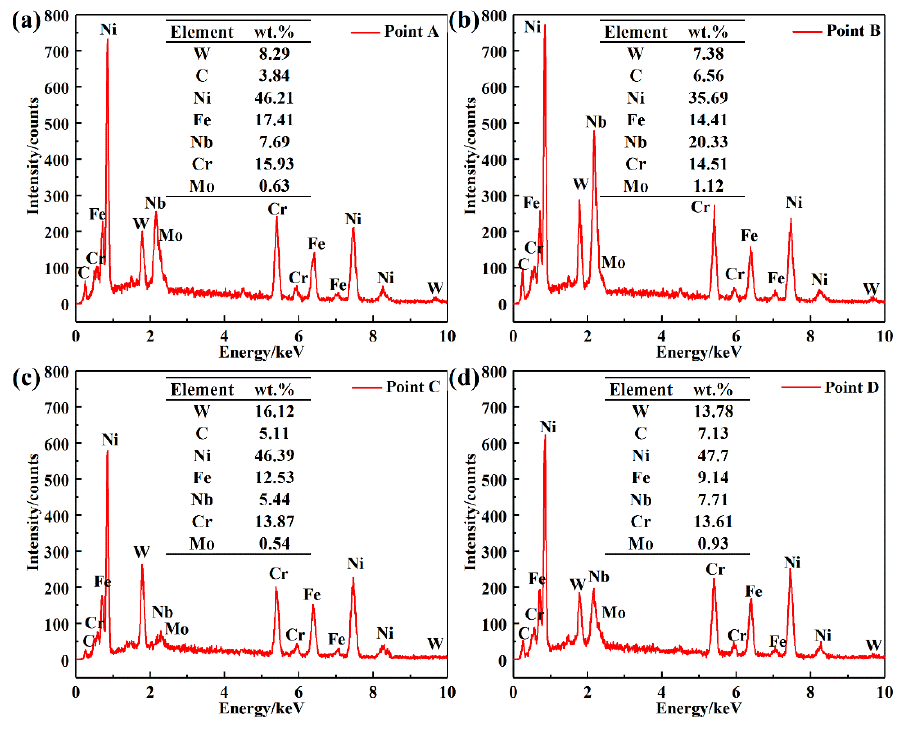
Figure 6. EDS analysis of the marked points: ( a ) A, ( b ) B, ( c ) C, and ( d ) D.